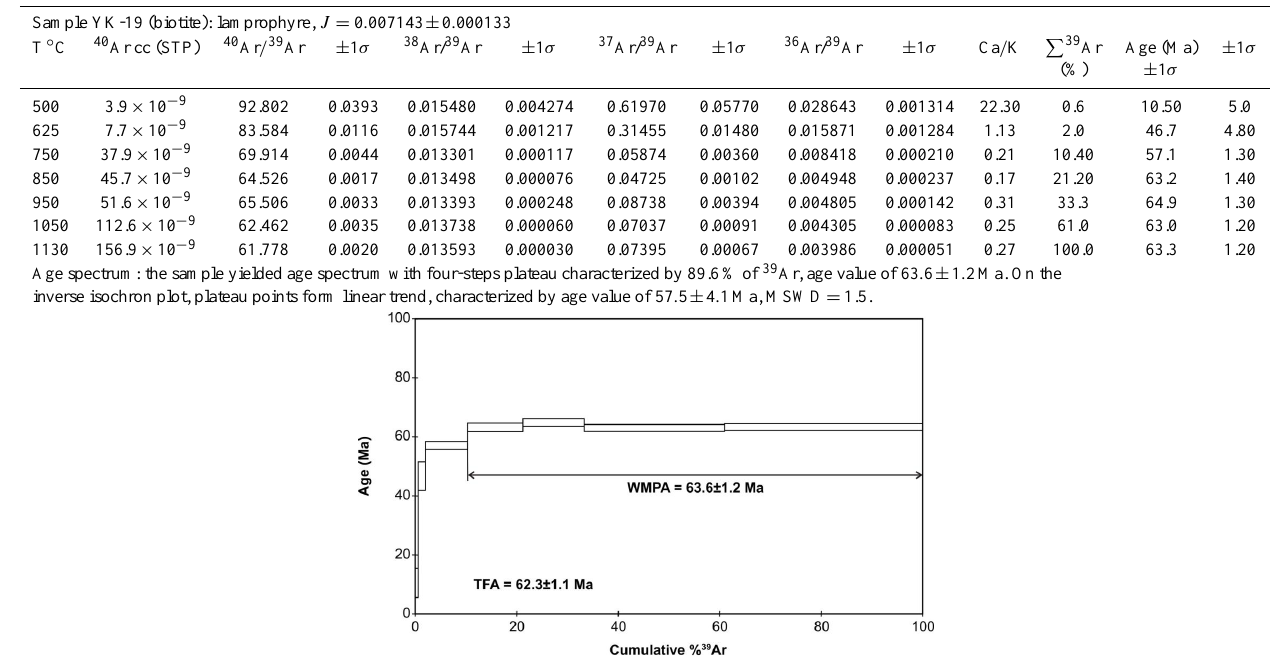
Age spectrum: the sample yielded age spectrum with three-steps plateau, characterized by 64.4% of 39 Ar, age value of 67 . 8 ± 4 . 9Ma. On the inverse isochron plot, points form linear regression characterized by age value of 68 . 1 ± 4 . 4 and ( 40 Ar/ 36 Ar) 0 = 296 . 1 ± 3 . 5.